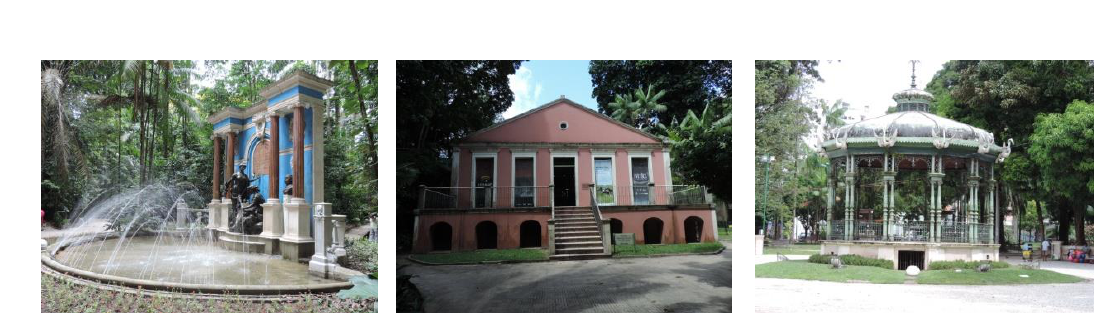
and other animals singing, of water fountains, as well as of road traffic or of other mechanical